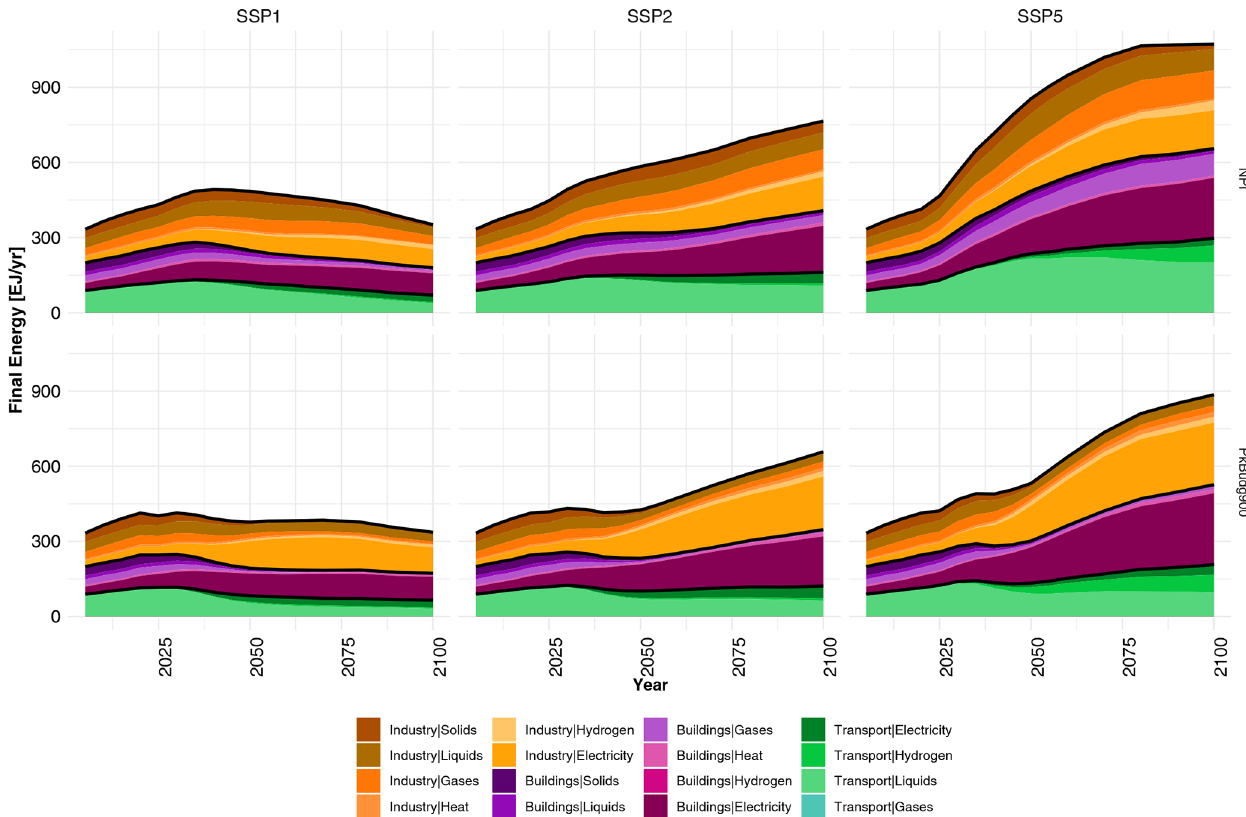
Figure 8. Final energy mixes for sectors by carrier for the NPi and pkBudg900 (1.5 ◦ C) scenarios of SSP1, SSP2, and